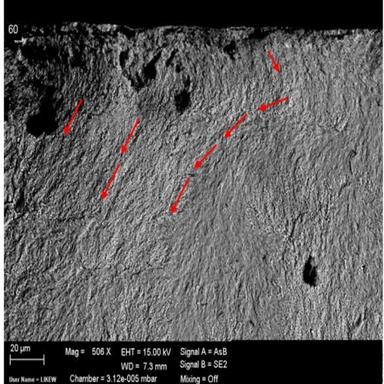
SEM picture of the fractography analysis of YSZ in water at a loading rate of 0.1 MPa/s; topographic information of the failure area reveals the direction of crack propagation following the weaker 5Y granules.